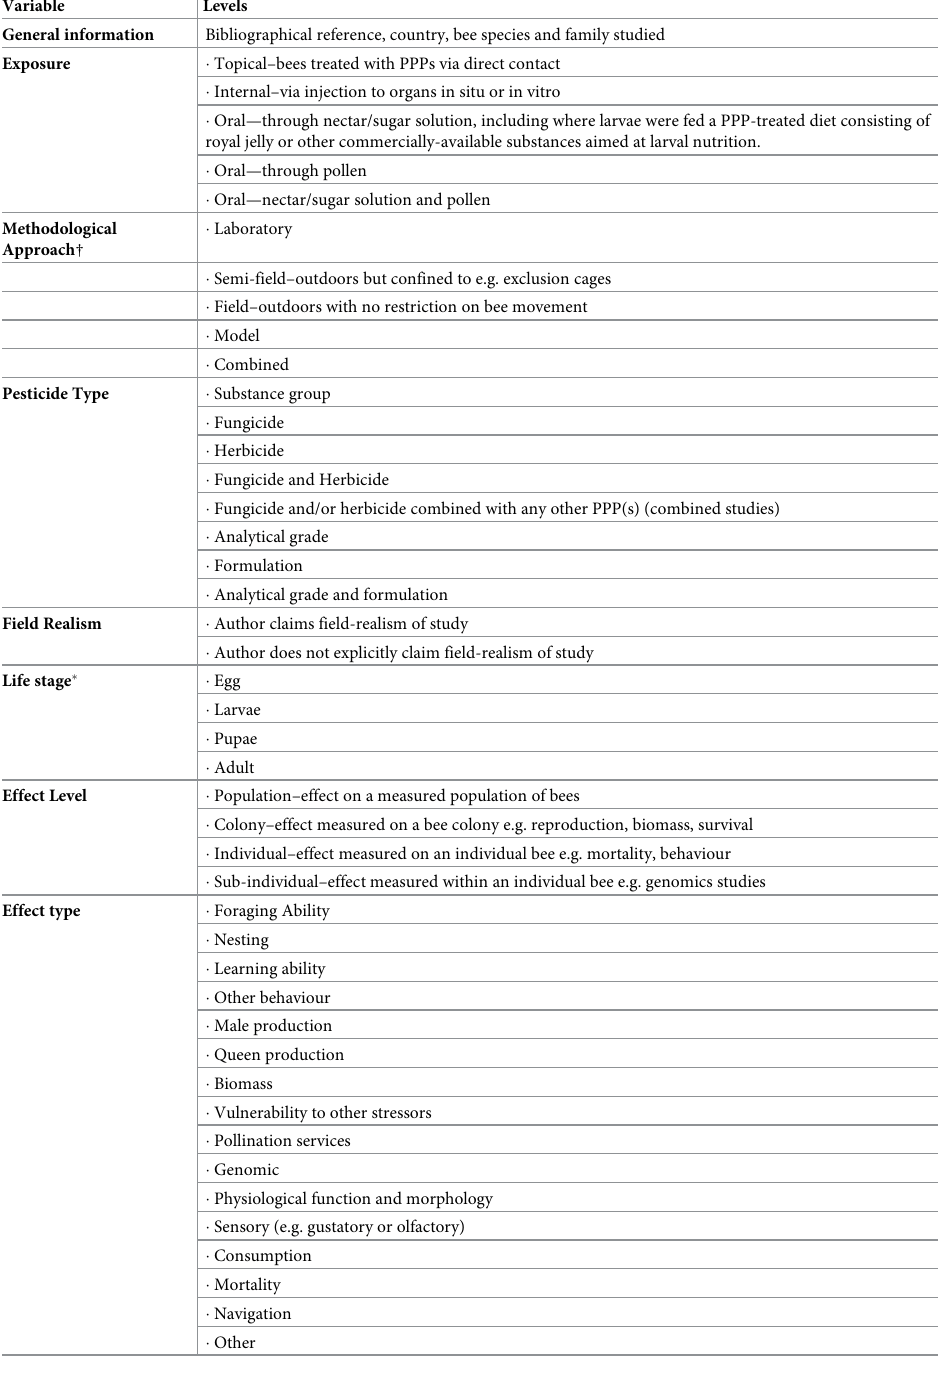
Table 1. The information extracted from each paper as part of the systematic